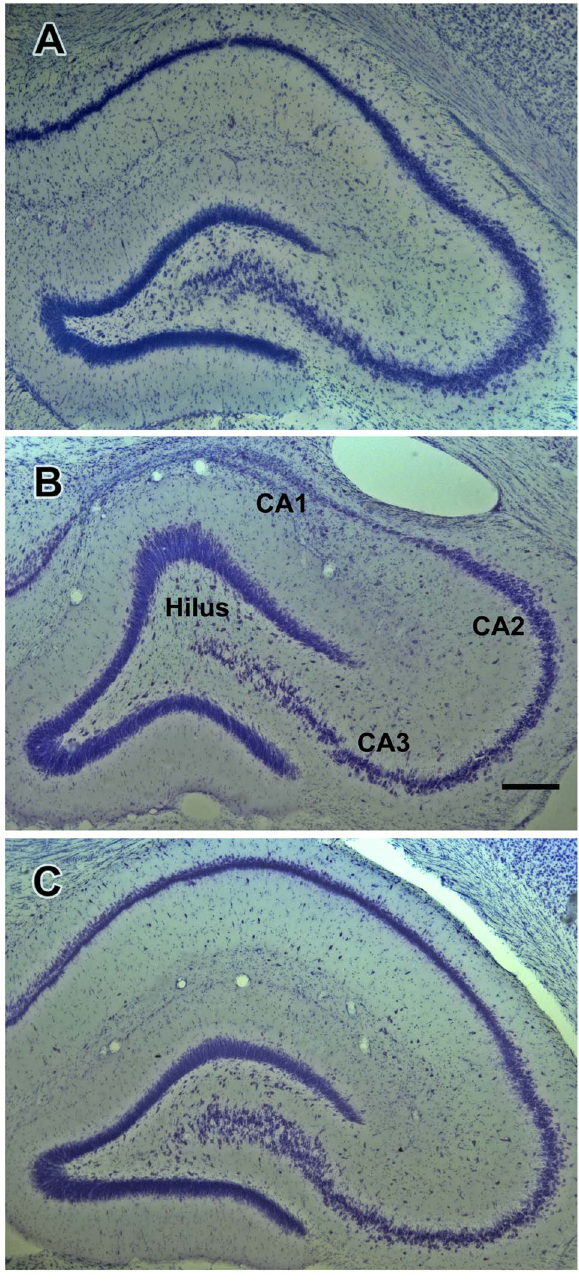
Figure 5. Effects of kainate treatment on hippocampal morphology. Photomicrographs of representative Nissl-stained coro- nal sections containing the dentate gyrus, CA3 and CA1 hippocampal fields taken from a control rat ( A ), from a rat in the behavioral status epilepticus (BSE) group ( B ) and from a kainate-treated rat that had not experienced behavioral status epilepticus (no-BSE; C ). Note that the density of neurons in the dentate hilus is considerably reduced in the rats with ( B ) and without ( C ) behavioral SE when compared to the control rat ( A ). Note also dramatic loss of the CA3 and especially CA1 neurons in the rat from the BSE group; neurons in the CA2 field are relatively preserved ( B ). Scale bar shown in ( B )=200 m m. doi:10.1371/journal.pone.0084722.g005 with the total number of neurons in the CA3 hippocampal field ( r =0.74, p , 0.0005 and r =0.6, p , 0.01 for the percentage of